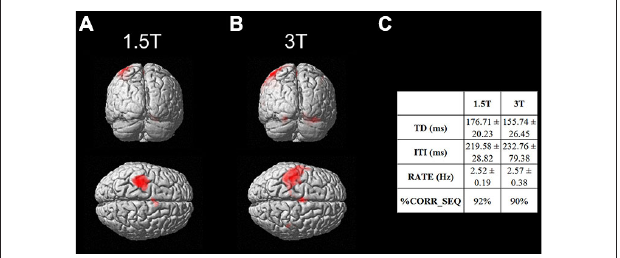
FIGURE 9 | Brain activation maps related to the finger motor sequence performed with the right hand. Results are displayed on a rendering surface in the neurological convention (left is left). One representative subject is shown at 1.5T (A) and 3T (B) , in the “with GAF” condition. In the table (C) , the kinematics parameters describing the motor performance are shown (TD: Touch Duration, ITI: Inter Tapping Interval, RATE: mean frequency during the finger motor task, %CORR_SEQ: percentage of correct